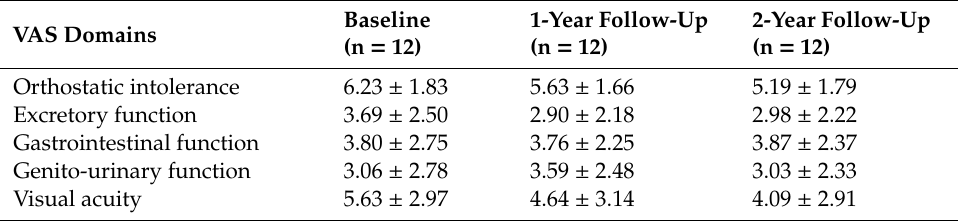
* indicates p < 0.05 vs. baseline. Results are expressed as mean ±